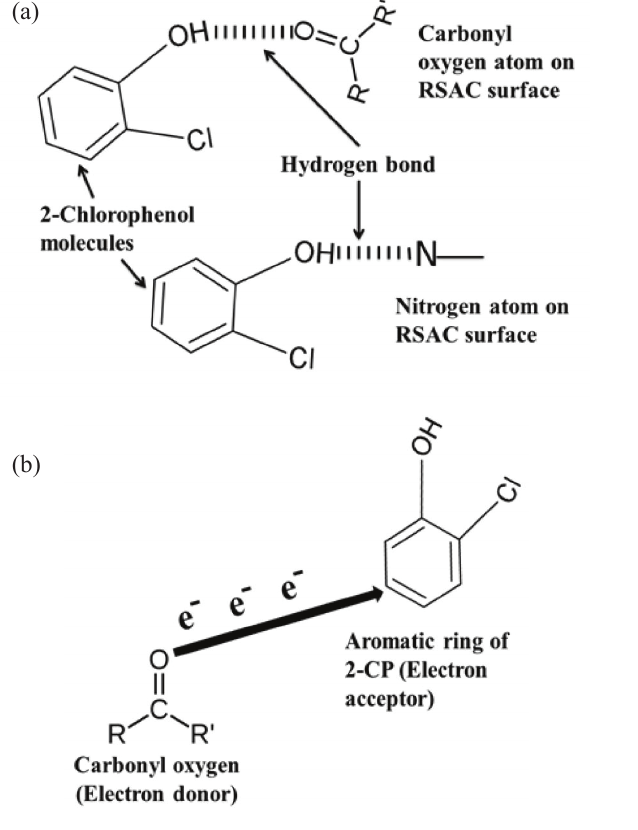
Fig. 10 – Schematics for the mechanism of 2-CP adsorption onto RSAC (a) H-bonding (b) Electron donor-acceptor complex